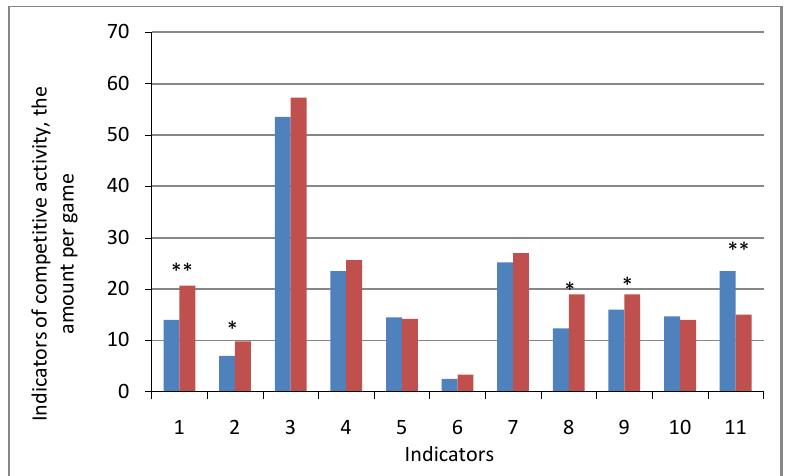
Fig.3. Indicators of competition functioning of Ukrainian women’s combined team (n = 12) and Lithuanian women’s combined team (n = 12) at basketball world championship for sportsmen with hearing problems: * - р<0.05; ** -